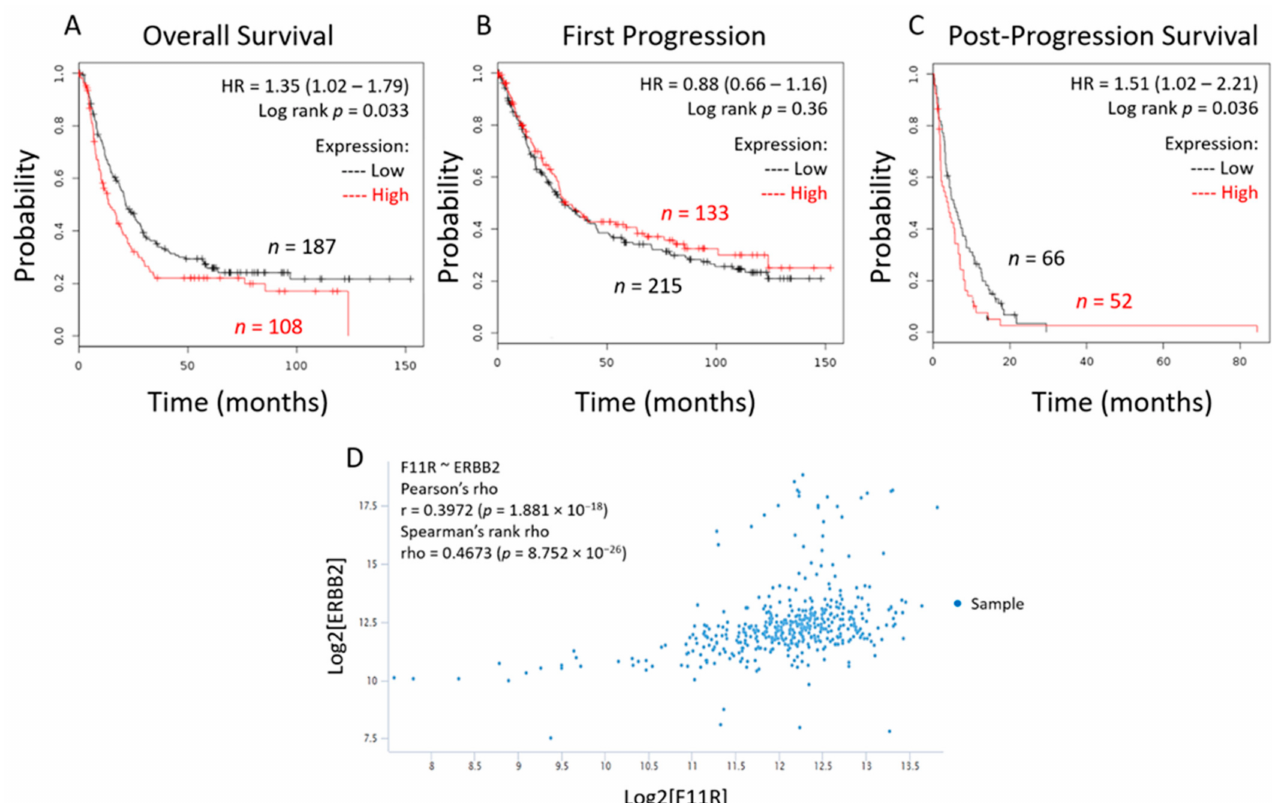
Figure 1. High JAM-A and HER2 expression predict worsened survival in gastric cancer patients. The Kaplan–Meier Plot platform (http://kmplot.com/analysis/ (accessed on 3 July 2019)) was used to generate survival curves in HER2- positive gastric cancer patient populations with high or low mRNA expression of JAM-A. Using F11R Jetset probes (excluding GSE62254 as recommended) in HER2-positive cases revealed that high mRNA expression of F11R (JAM-A) was associated with worsened overall survival ( A ) and post-progression survival ( C ), but not time to first progression ( B ). The Xenabrowser platform (https://xenabrowser.net/ (accessed on 28 August 2019)) was used to generate a scatter plot ( D ) showing correlations between JAM-A and HER2 mRNA expression in gastric cancer patients. Using the JAM-A and HER2 genes (named F11R and ERBB2, respectively) as variables in the TCGA Stomach Cancer cohort, a statistically significant moderately positive correlation was observed ( D